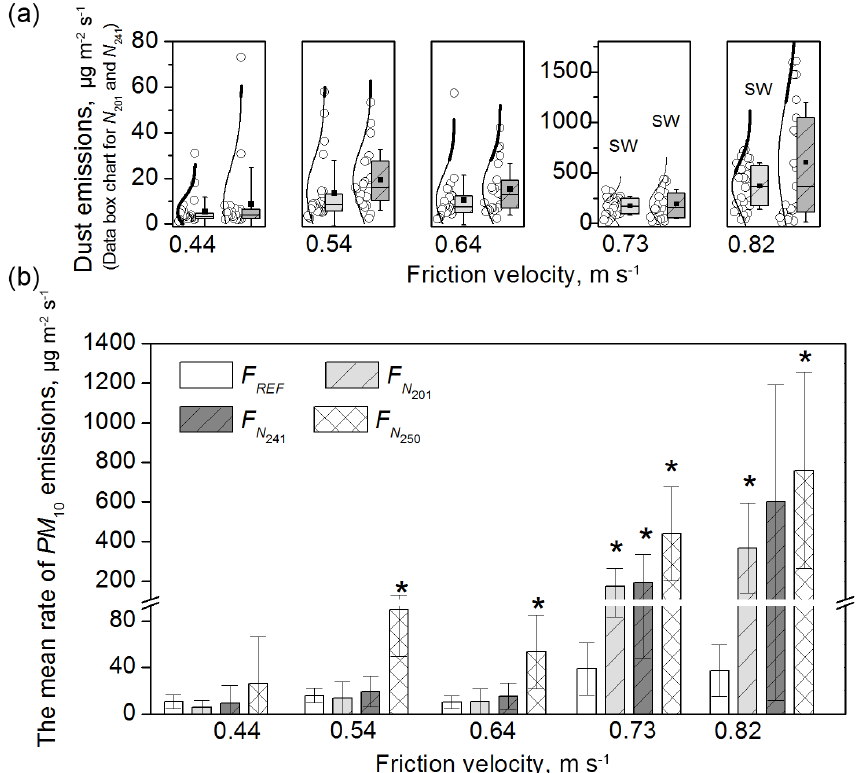
Figure 4. (a) Measured dust fluxes from the trampled surfaces with N values of 201 and 241headha − 1 . Open circles ( ◦ ) and curved lines ( (cid:111) ) denote collected dust data and normal distributions, respectively. Center dots ( · ) and dashes ( − ) in the boxes denote the means and medians of dust emissions, respectively. The openings and closings of the boxes present the 25 and 75th percentiles for each dataset. SW denotes statistically significant datasets with the Shapiro–Wilk normality test. (b) Mean dust emissions fluxes with SDs on correspondent friction velocities. The significant differences ( p value with a significance level of 0.05) for mean dust emissions of the trampled surfaces from the F REF on each friction velocity are denoted by ∗